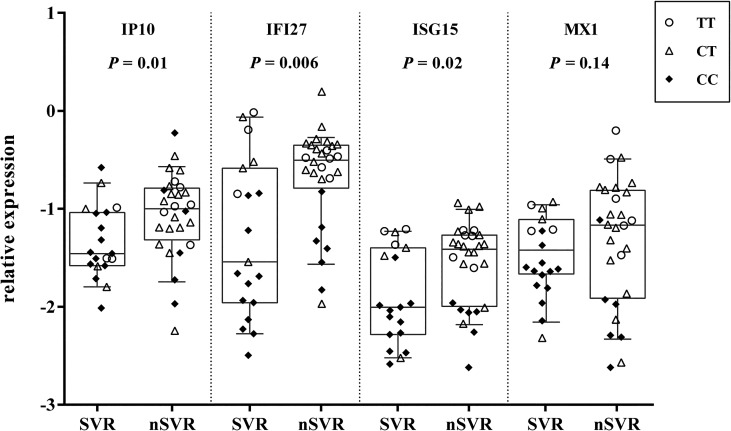
Relationship between hepatic expression of IP10, IFI27, ISG15, and MX1 and treatment outcome in individual cases.Empty circles, rectangles, and filled diamonds represent TT, CT, and CC rs12979860 genotypes, respectively. The y-axis shows the relative unit of a given gene, normalized to GAPDH in log scale, as a box plot displaying the 10th, 25th, 50th, 75th, and 90th percentiles of gene expression levels. Each dot represents one sample. The P values were obtained by the Mann-Whitney test (for SVR, n = 19; non-SVR [nSVR], n = 28).